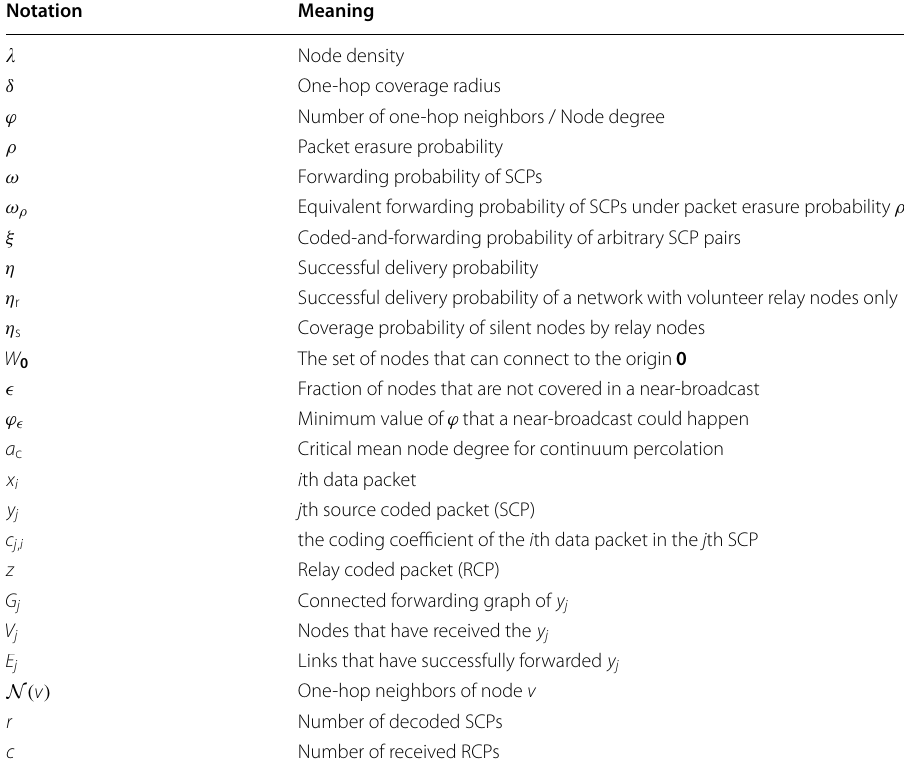
Table 1 Summary of parameters